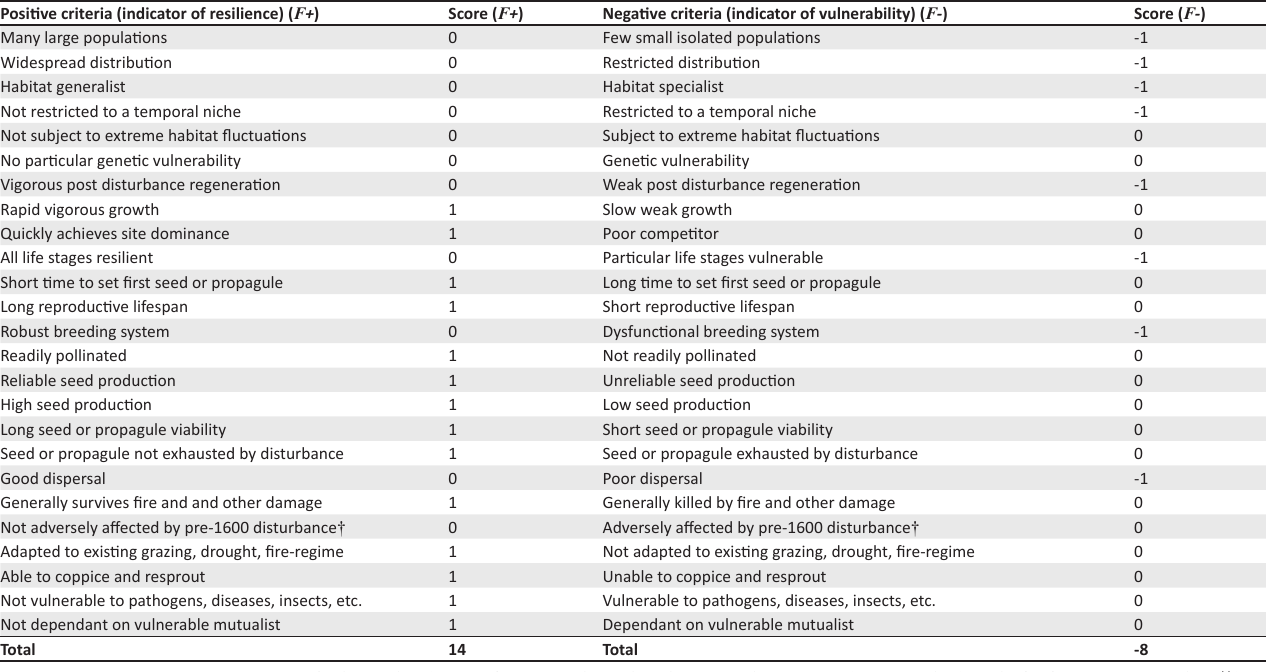
TABLE 1: Determination of the ecological factor score and adjustment percentage of Brackenridgea zanguebarica . Positive criteria (indicator of resilience) ( F + )